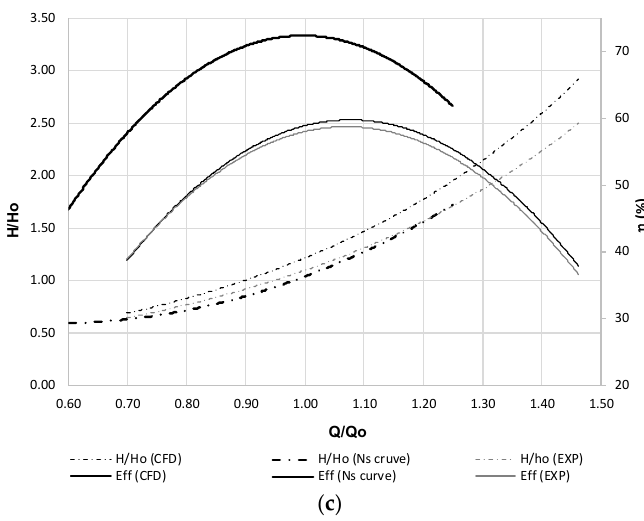
Figure 12. Performance curves and selection of a PAT. ( a ) Characteristic curves for different N s [19]; ( b ) comparison between CFD, experimental for the tested PAT and Ns curve: Variation of the efficiency and head number with the discharge number; ( c ) dimensionless head and flow characteristic curves. Reproduced with permission from [19].